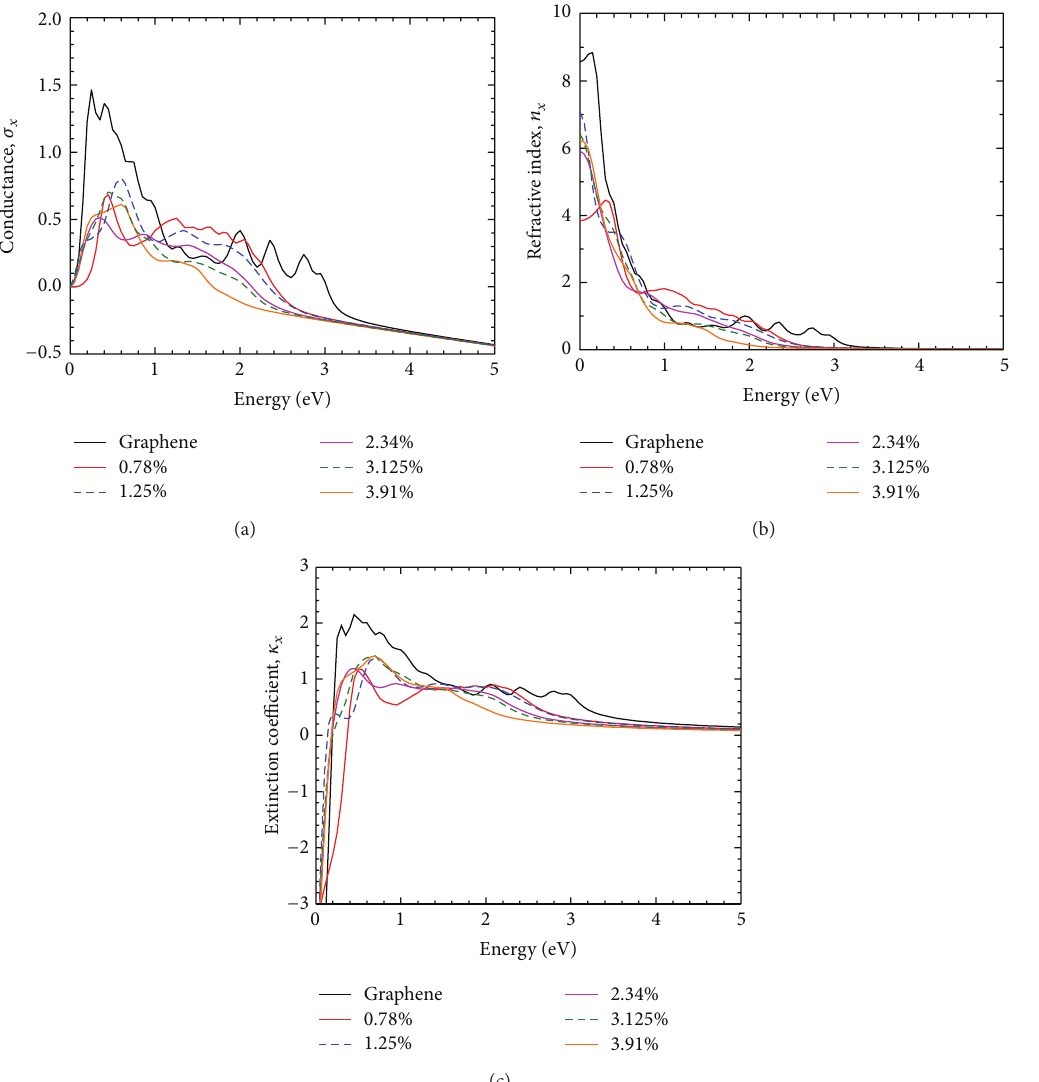
Figure 6: The calculated conductance (a), refractive index (b), and extinction coefficient (c) as function of energy for the various substitutions concentrations of gallium (0, 0.78, 1.56, 2.34, 3.13, and